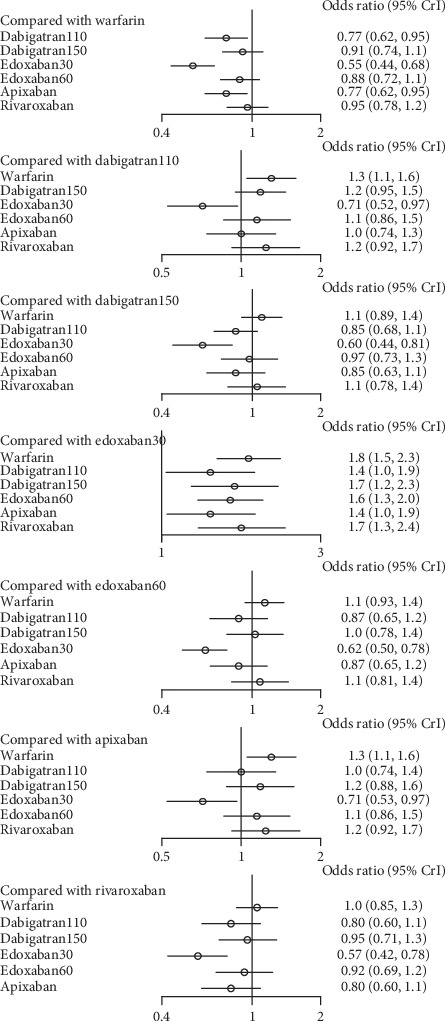
Forest plot for the safety of the comparison among different treatments of patients with mild renal function.